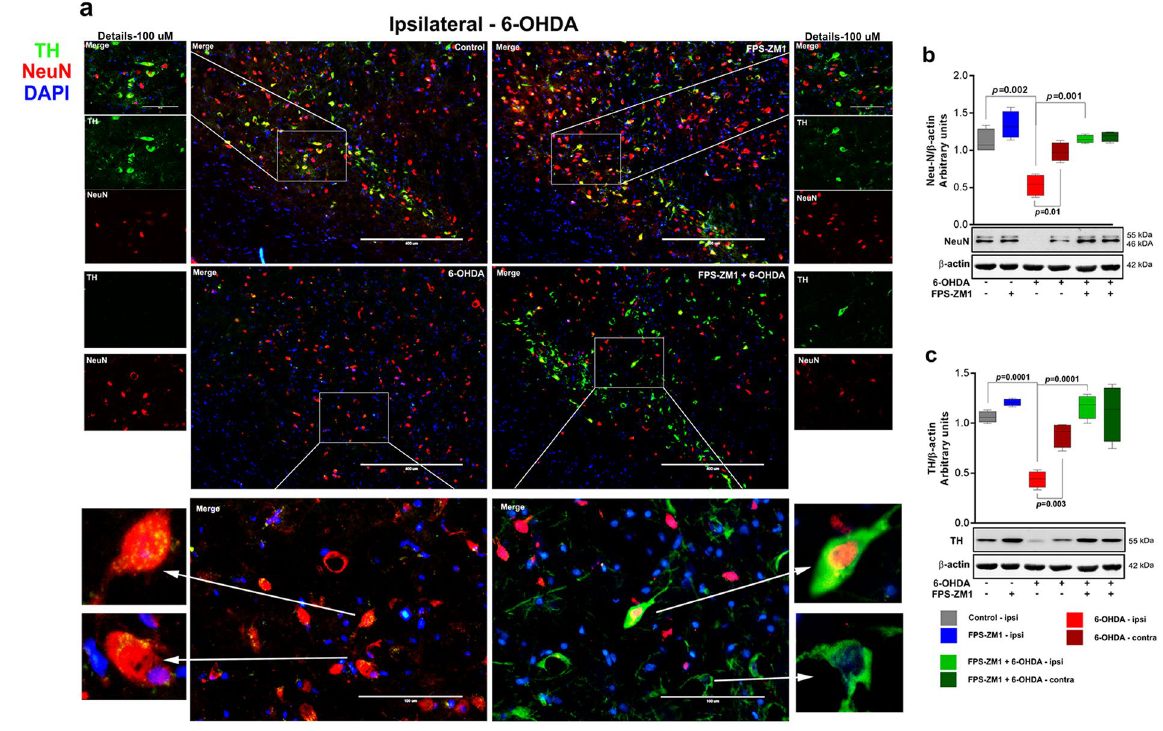
Figure 6. FPS-ZM1 inhibited 6-OHDA-induced neuronal death. Tissues were prepared for immunofluorescence and western blotting 15 days after 6-OHDA administration. ( a ) Representative immunofluorescence images of SN immunostained for TH, NeuN, and DAPI ( n = 10 per group). The ipsilateral sides are shown. The microscopy images were taken with 400 μ m of magnification and the squares represents the approximation to 100 μ m. ( b ) Representative western blots and quantification of NeuN ( n = 6 per group) and c ) TH ( n = 6 per group). Each color in the graph represents a group and a brain location: gray - control/ ipsilateral side; blue - FPS-ZM1/ipsilateral side; red - 6-OHDA/ipsilateral side; dark red - 6-OHDA/contralateral side; green - FPS-ZM1 + 6-OHDA/ipsilateral side; dark green - FPS-ZM1 + 6-OHDA/contralateral side. Values represent mean ± SD. One-way analysis of variance and Bonferroni Multiple Comparison post-hoc test were applied to all data. p values are embedded in the figure.